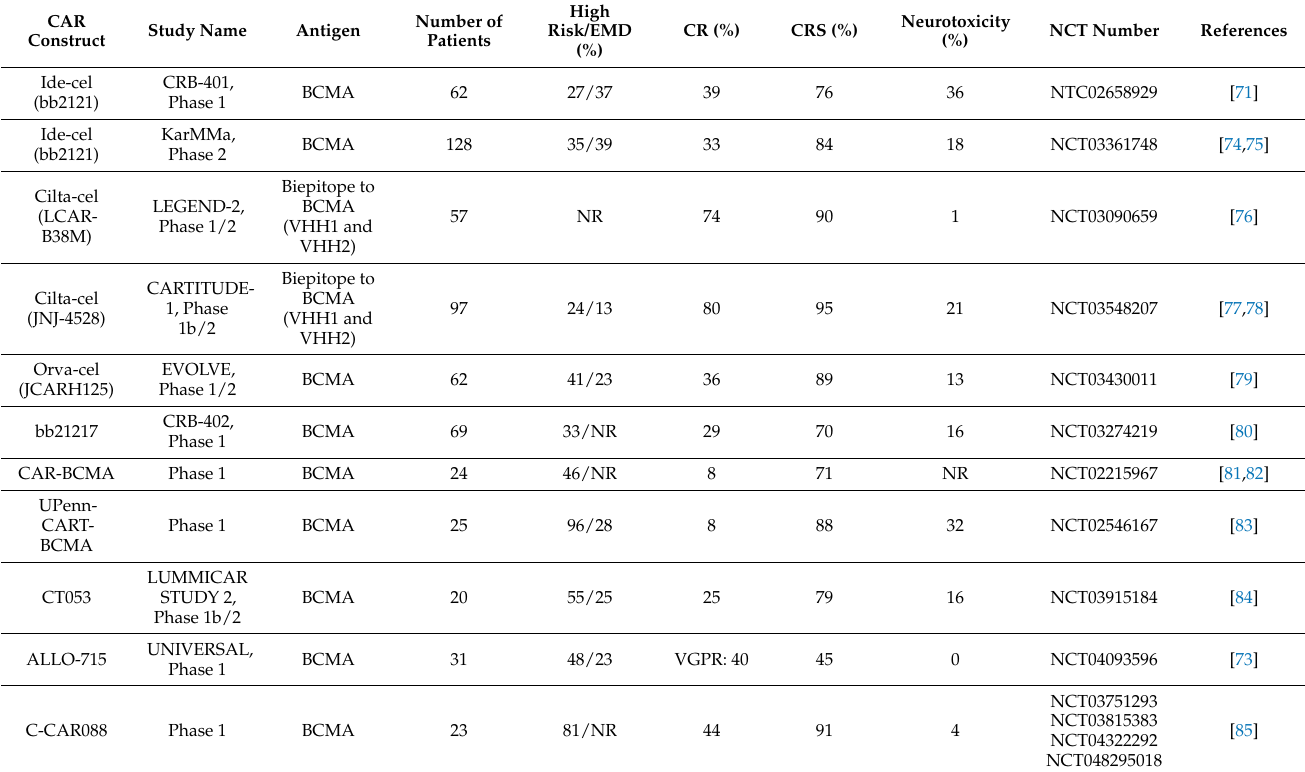
Table 2. Characteristics, efficacy, and safety data from selected clinical trials of anti-BCMA CAR T cell constructs in